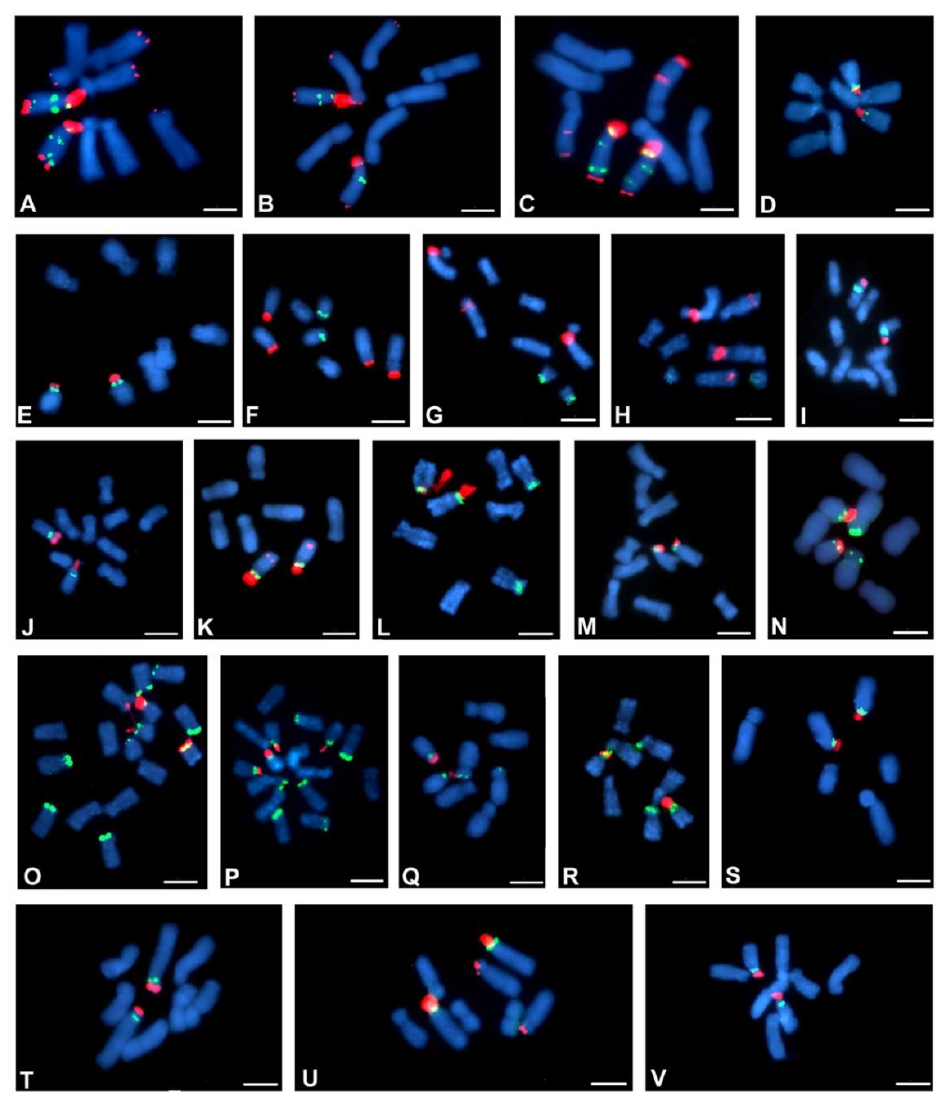
Figure 5. Localisation of 35S and 5S rDNA loci in metaphase chromosomes of Crepis species. Fluorescent in situ hybridisation was performed with 5S rDNA (green fluorescence) and 25S rDNA probes (red fluorescence). ( A ) — C. conyzifolia 2, ( B ) — C. conyzifolia subsp. dshimilensis , ( C ) — C. conyz- ifolia 1, ( D ) — C. nigrescens , ( E ) — C. tectorum , ( F ) — C. nicaeensis , ( G ) — C. setosa 1, ( H ) — C. setosa 2, ( I ) —